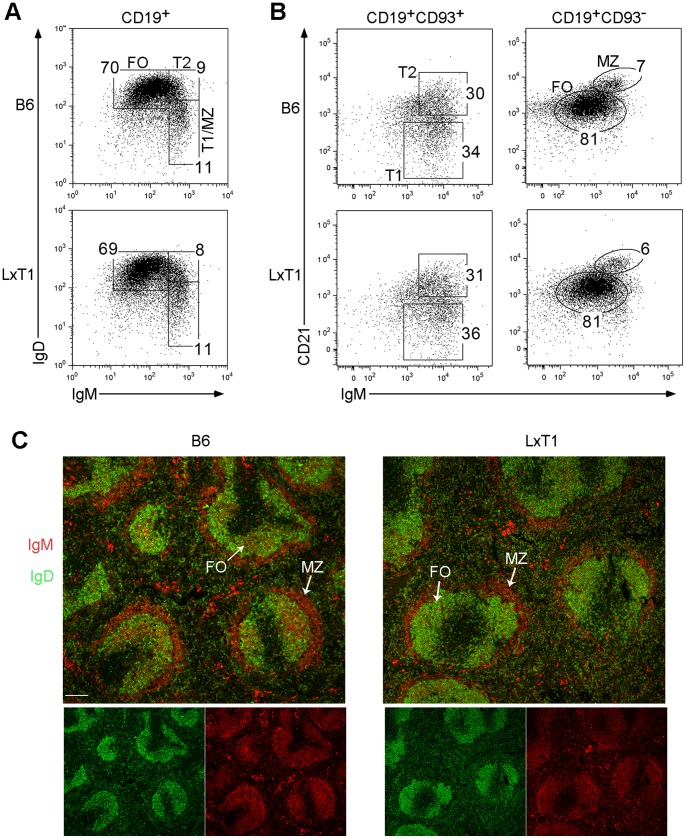
Normal distribution of B cell populations in LxT1 mice.Flow cytometry analysis of spleen cells from two to four months old B6 and LxT1 mice. Compared to B6, LxT1 mice show normal development of B cell populations based on the expression of IgM vs IgD, gated on CD19+ cells (A) and IgM vs CD21 (B), gated on CD19+ with/without CD93. (A) T1/MZ, (IgMhiIgDlow); T2, (IgMhiIgDhi); FO (IgMlowIgDhi). (B) T1 (CD93+IgMhiCD21−); T2 (CD93+IgMhiCD21+); FO (CD93−IgMlowCD21int); MZ (CD93−IgMhiCD21hi). Representative data from one out of three experiments. (C) Immunofluorescence staining of spleen cryosections from LxT1 (n = 6) and B6 mice (n = 3) shows normal localization of FO and MZ B cells after staining for IgM (red) and IgD (green). 10× objective, bar, 100 µm.